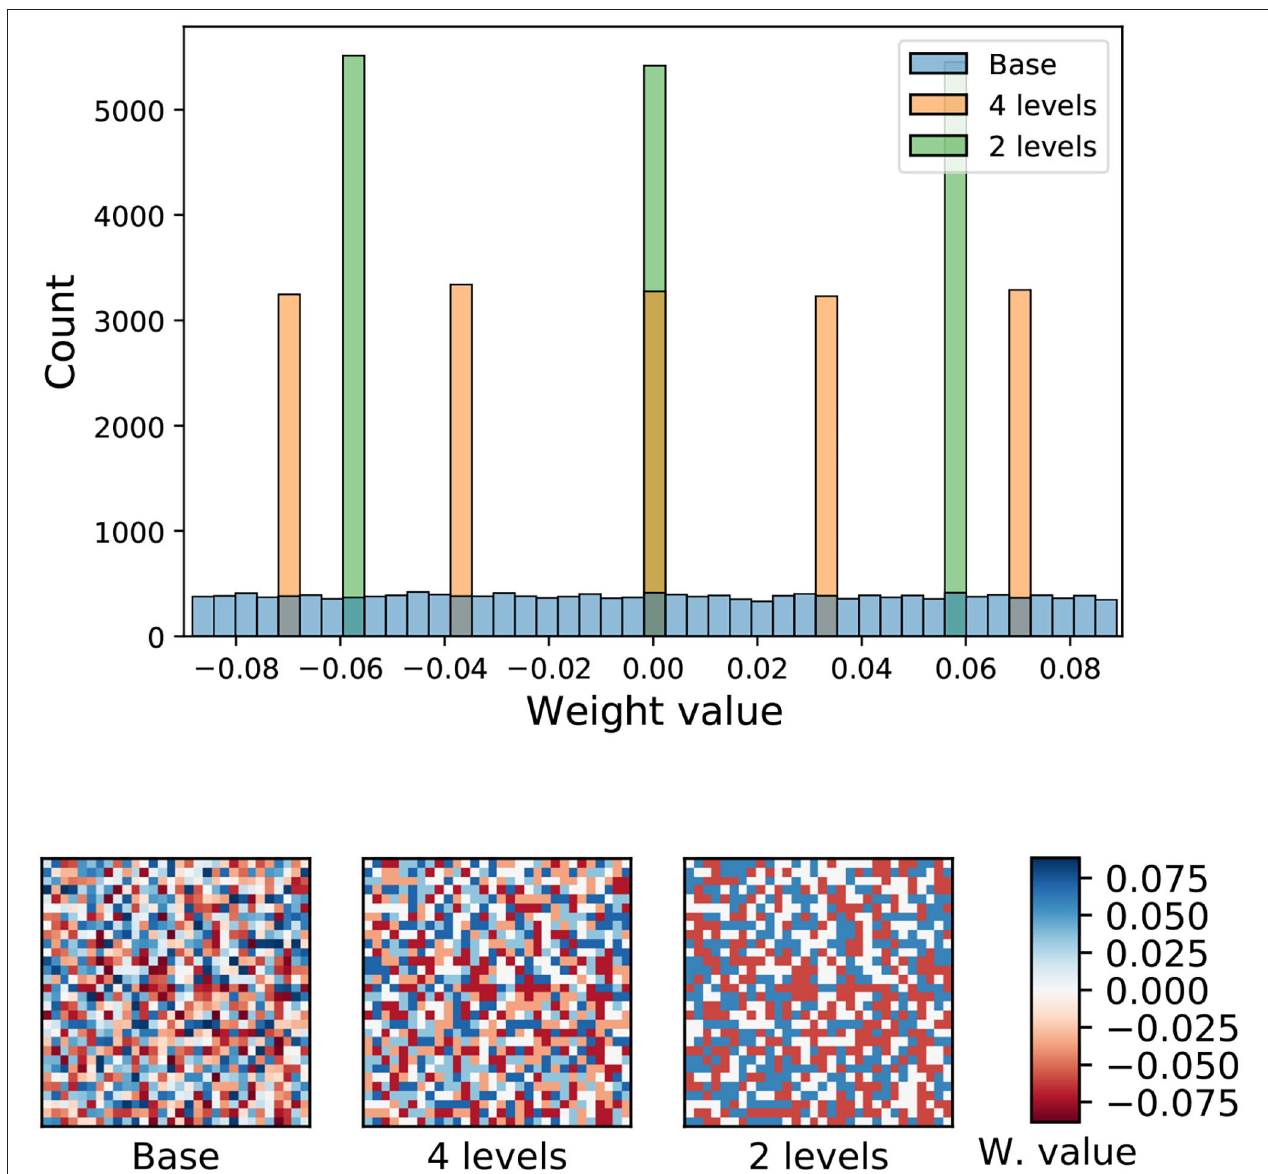
FIGURE 7 | Top: Weight distribution of the liquid-to-liquid synapses for three different precisions. Bottom: 2D representation of the weight values for the three quantization schemes. For this example, a liquid population of 128 was considered. Each resulting 128